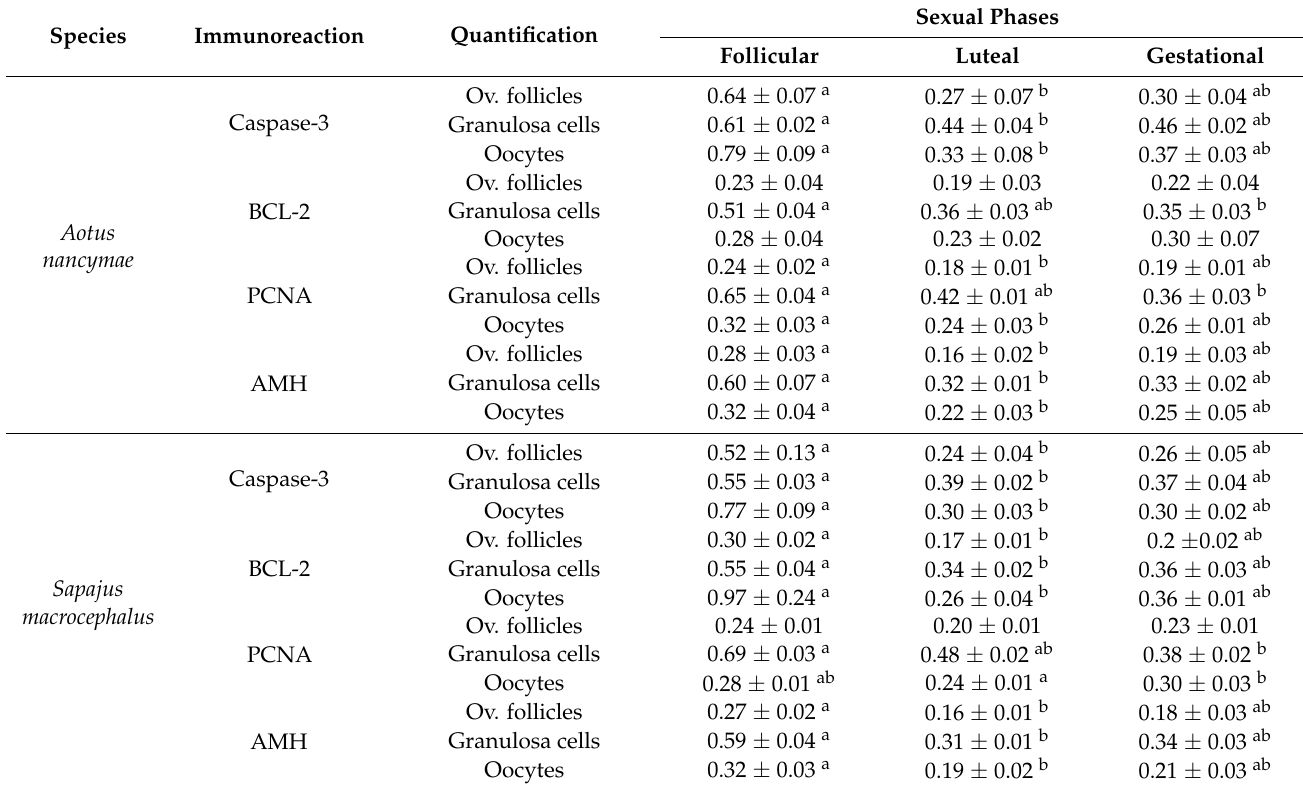
Table 3. Number of ovarian follicles (Ov. follicles), granulosa cells, and oocytes immunostained for Caspase-3, BCL-2, PCNA, and AMH by sexual phases in Ma’s night monkeys ( Aotus nancymae , n = 6) and large-head capuchins ( Sapajus macrocephalus , n = 6).